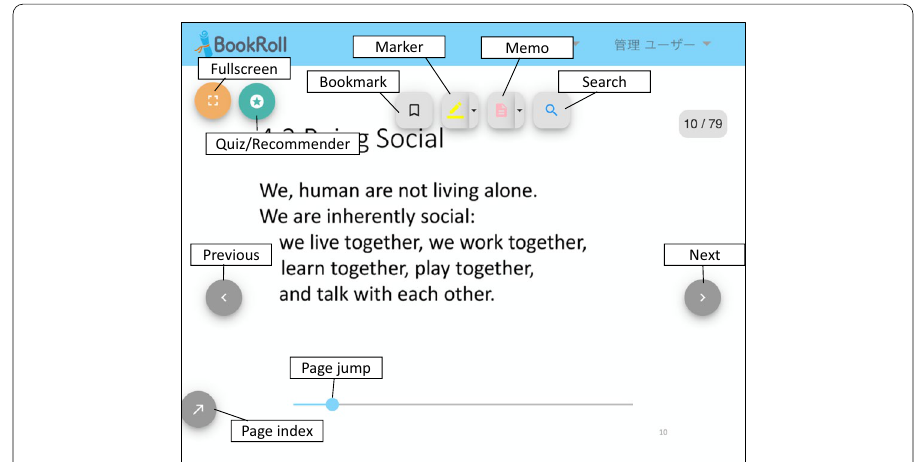
Fig. 3 A screenshot of the BookRoll digital learning material